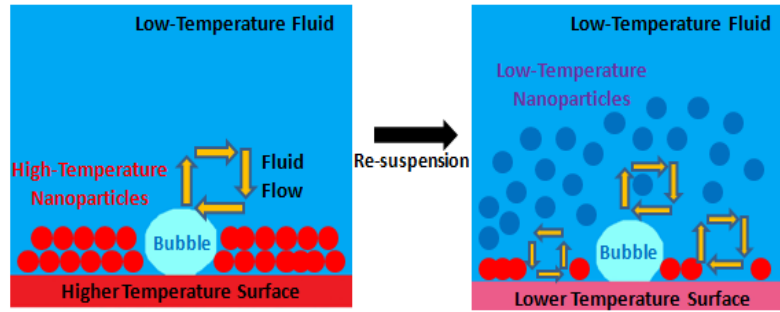
Figure 8. Fluid flow and heat transfer of the nanoparticle